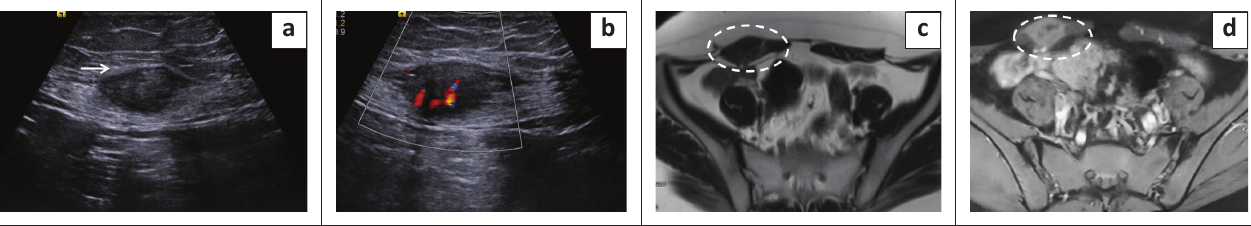
FIGURE 6: (a–d) Involvement of rectus abdominis by scar endometriosis in a 24-year-old lady who complained of continuous debilitating lower abdominal pain. Ultrasound image (a) shows an oval hypoechoic lesion within the right rectus muscle (RM), which appears to be displaced around it (arrow). It shows irregular, infiltrating margins and significant internal vascularity on colour Doppler (b). On axial T2 W MRI (c), bulging contours of the right RM were appreciated with no obvious signal change. Axial post-contrast T1 W image (d) shows avid enhancement, which allowed better delineation of the